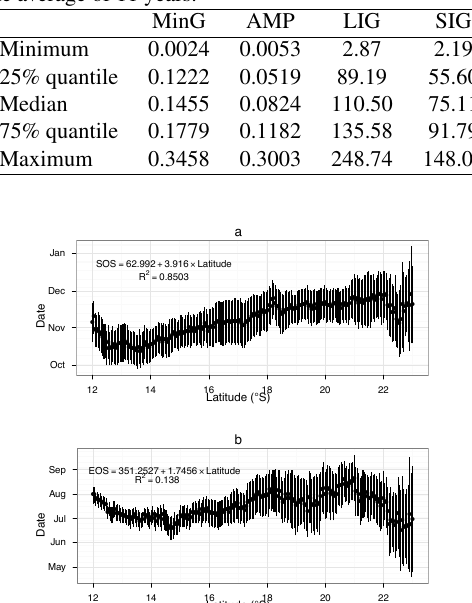
Figure 3: Spatial patterns of 11 years (2000-2011) mean EOS (the date of growing season end) in the NATT. The numbers in the bracket indicate the calendar years, which 1 means first half of phenological year, i.e. from July 1 to December 31, 2 means second half of pheno- logical year, i.e. from next January 1. Original 0.05 de- gree resolution result had been aggregated to 0.2 degree resolution for plotting purpose.